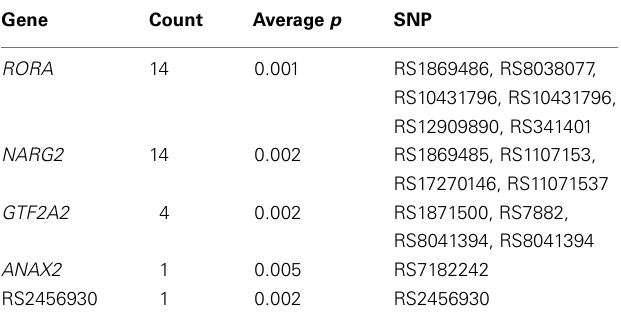
Table 7 |Analysis of repeats by gene within top-10 significant association for each of the thirteen traits.